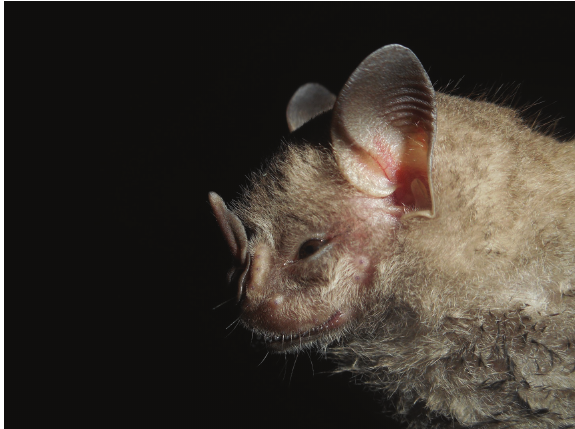
Figure 4. Adult male of Artibeus inopinatus captured in Cas- co Urbano, Langue, Valle in southern Honduras. This was the smallest individual recorded in our study (all measurements in mm): Ca = 6.51, FA = 50.66, BL = 54.35, 3mt = 46.21, 1ph = 14.88, 2ph =23.19, 3ph = 15.95, and W = 25.90